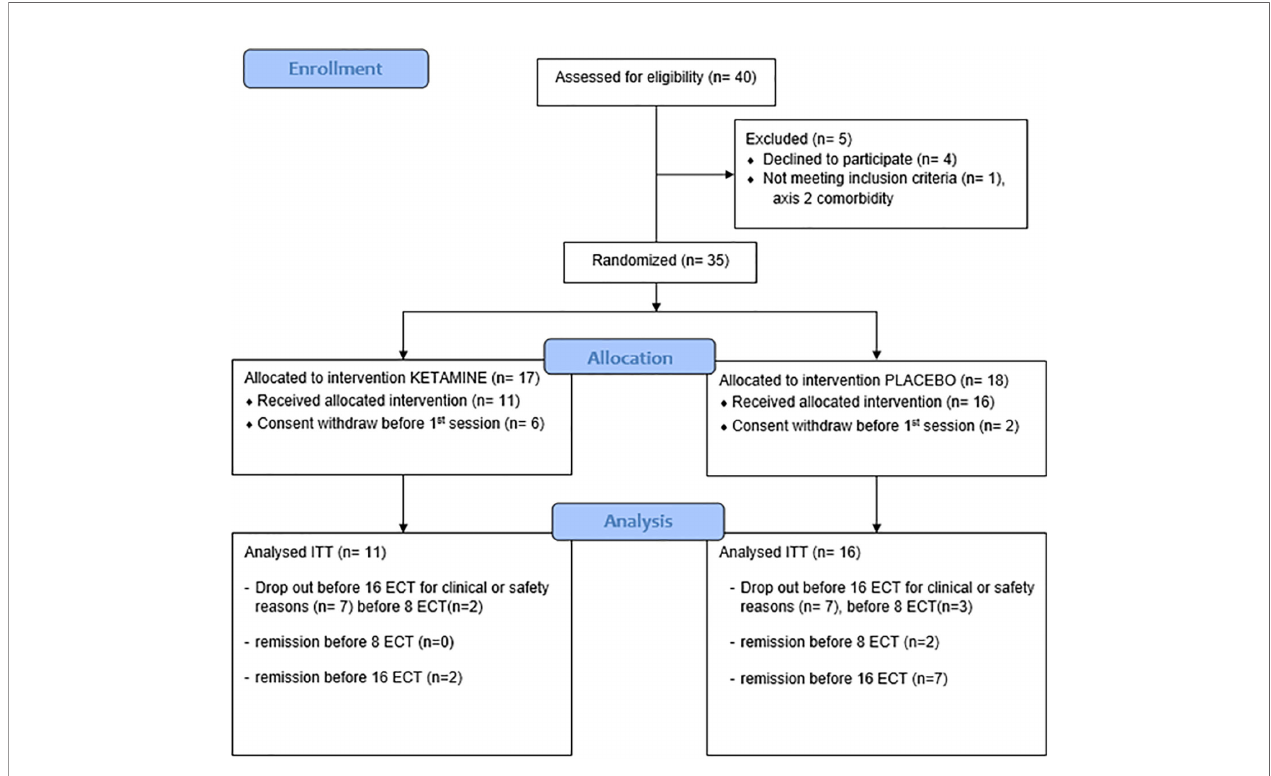
FIGURE 1 | Consort fl ow diagram of